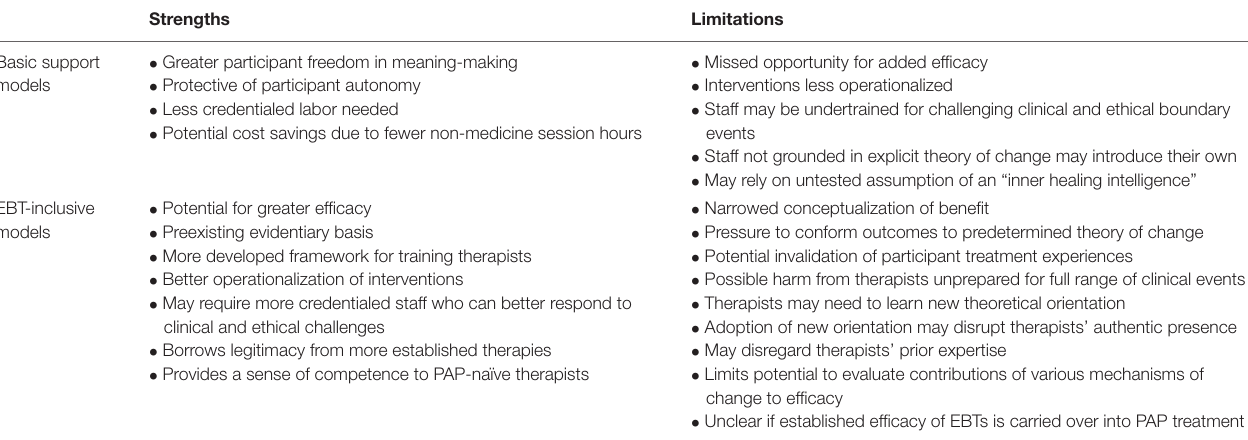
TABLE 2 | Comparative strengths and limitations of basic support and EBT-inclusive models.